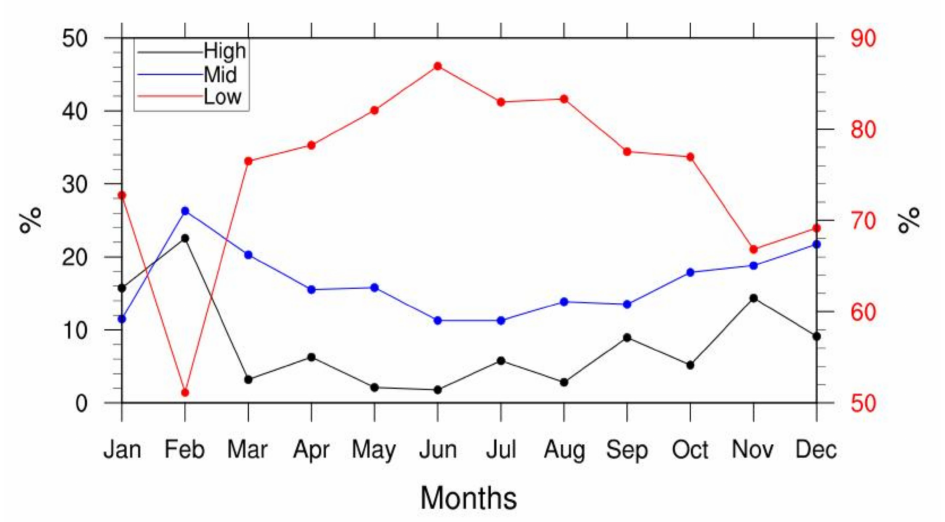
Figure 5. Monthly mean cycle of low (red, lowest CBH < 2000 m), mid (blue, 2000 m < lowest CBH < 5000 m) and high (black, lowest CBH > 5000 m) clouds expressed in percentage. The left Y-axis refers to the mid and high-level clouds and the right Y-axis for low-level